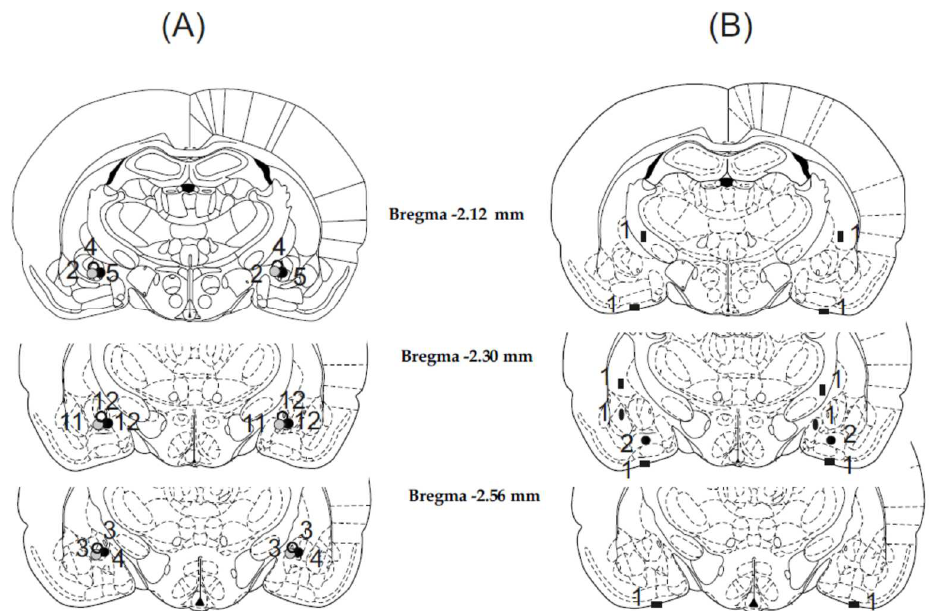
Figure 1. Illustration of reconstructed injection sites. Correct bilateral injection placements are indicated as closed circles in the CeA on panel ( A ) (n = 56). Incorrect injection placements are indicated on panel ( B ) (n = 8). Brain structure diagrams of coronal sections are adapted from the stereotaxic atlas of Paxinos and Watson. The numbers refer to anterior–posterior distance from bregma in mm. Identical symbols (black and grey dots and empty circles) on panel ( B ) indicate coherent injection sites of bilateral injections. Numbers above marked sites on panels ( A ) and ( B ) indicate numbers of animals.